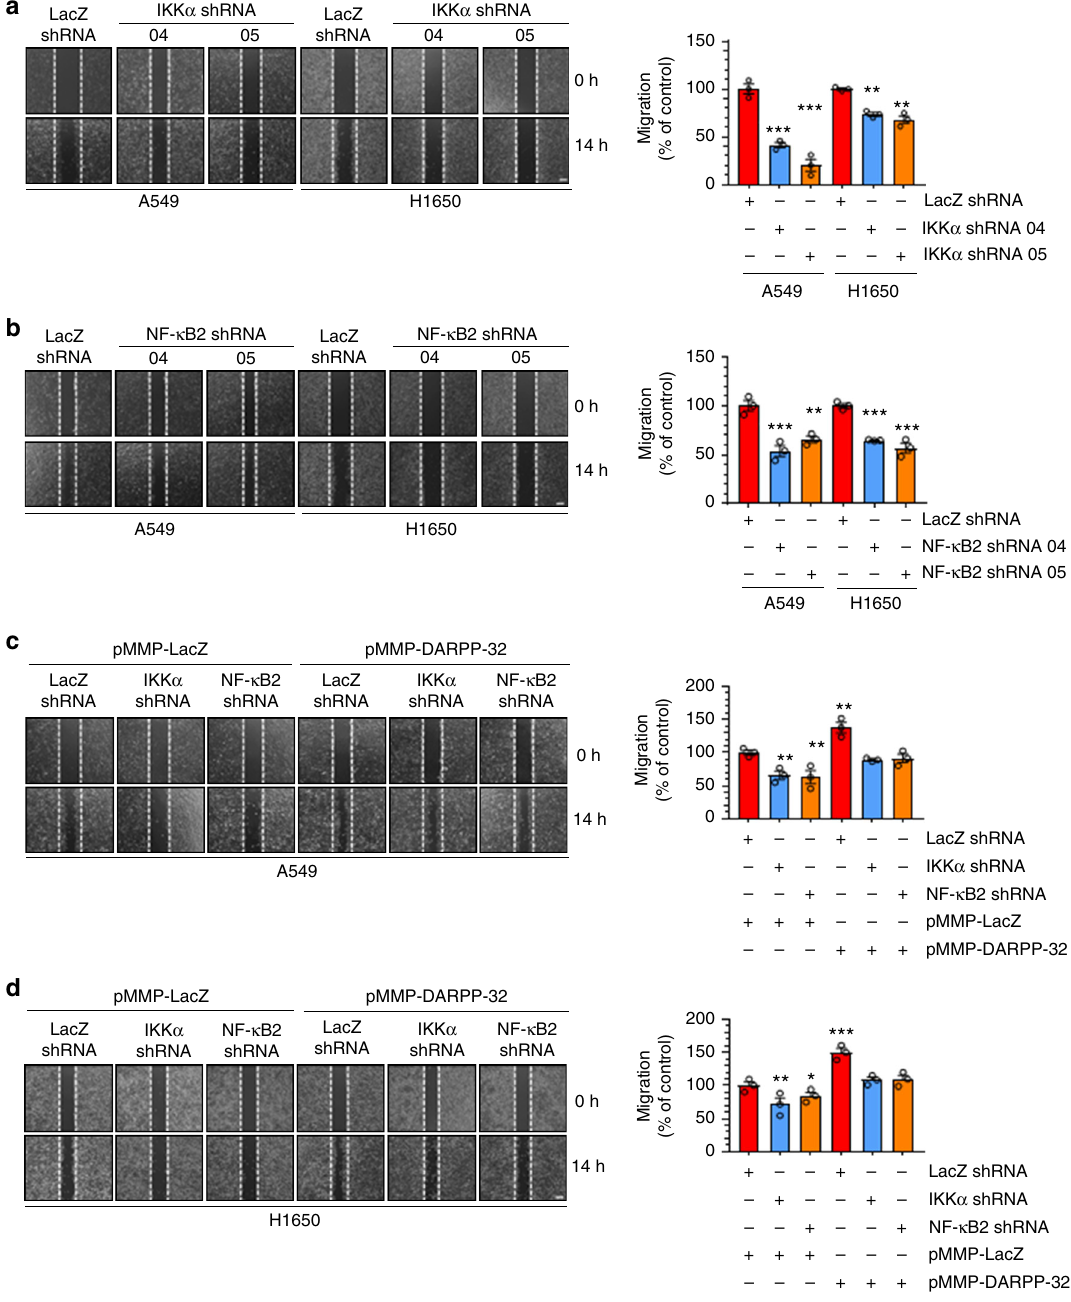
Fig. 5 Knockdown of IKK α and NF- ĸ B2 reduces lung cancer cell migration. a A549 and H1650 cells transduced with lentivirus encoding control or IKK α shRNAs (clone numbers 04 and 05) were plated into 60 mm cell culture dishes, scratched and imaged at 0 and 14 h. b A549 and H1650 cells transduced with lentivirus encoding control or NF- ĸ B2 shRNAs (clone numbers 04 and 05) were scratched and imaged at 0 and 14 h. c A549 and d H1650 cells expressing control, IKK α or NF- κ B2 shRNAs were transfected with control (pMMP-LacZ) or DARPP-32 (pMMP-DARPP-32) overexpressing plasmids using Polyfect reagent. The cells were then scratched and imaged at 0 and 14 h. Dashed lines indicate the boundary of the edges of the wound at 0 h. Experiments were repeated at least three times in triplicate. Each open circle on a graph represents an independent experiment. Scale bar, 200 µ m. Distance traveled by the migratory cells were calculated using ImageJ software. Results represent mean ± SEM ( n = 3). * P < 0.05, ** P < 0.01 and *** P < 0.001, one-way ANOVA followed by Dunnett ’ s test for multiple